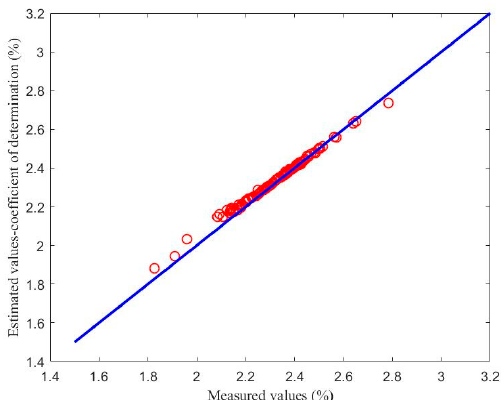
Figure 9. Comparison between the soft sensor based on LSSVM and laboratory measurements.